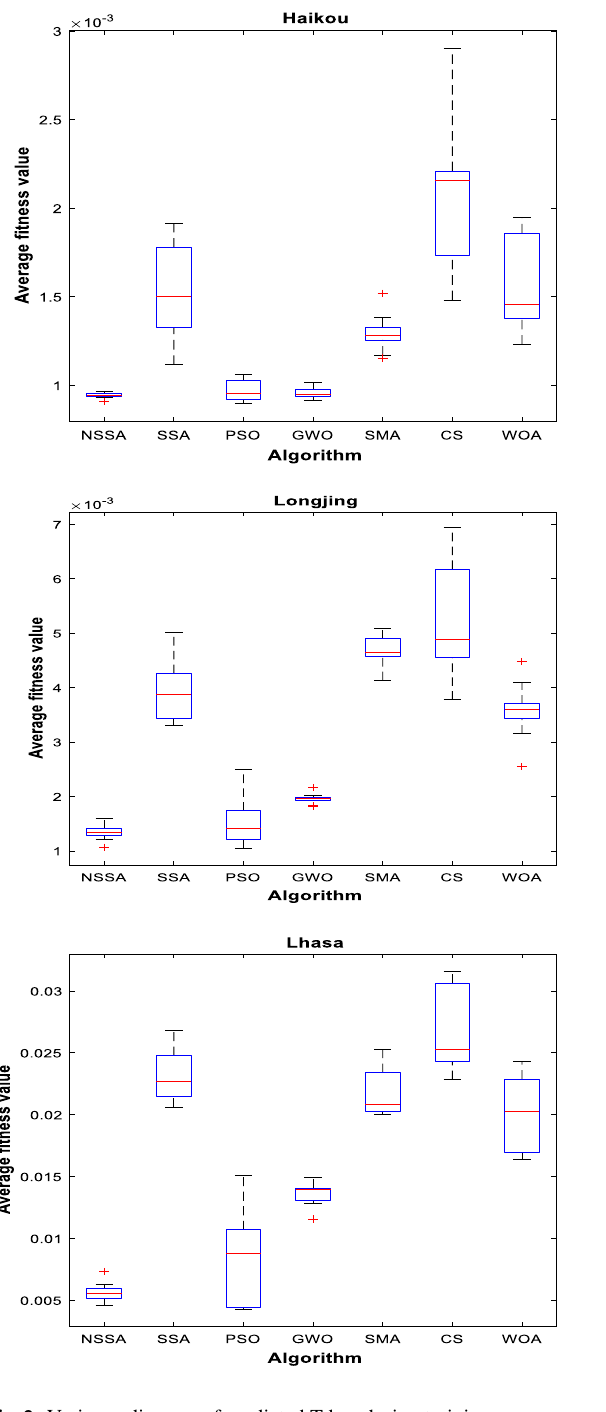
Fig. 9 Variance diagram of predicted Tdew during